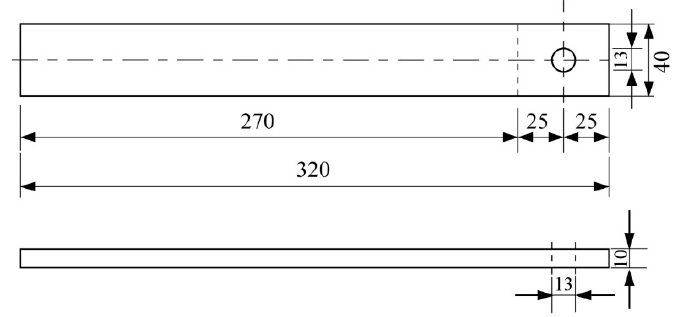
Figure 2. Dimensions of the beam component (mm).